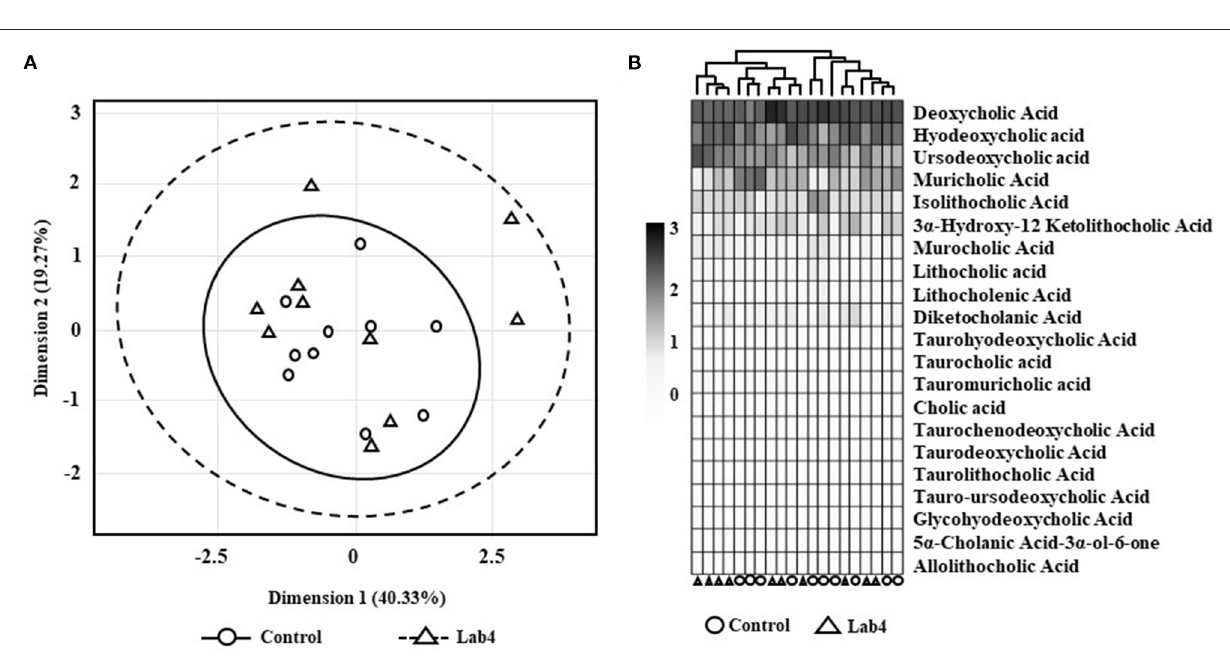
Supplementary Figure S3 ]. TNF- α levels correlated